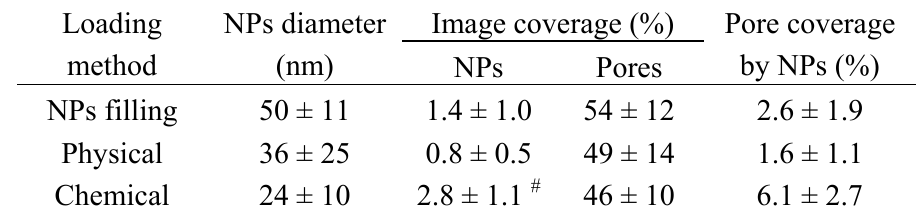
Table 1. Summary of morphological parameters extracted from the SEM images similar to those in Figure